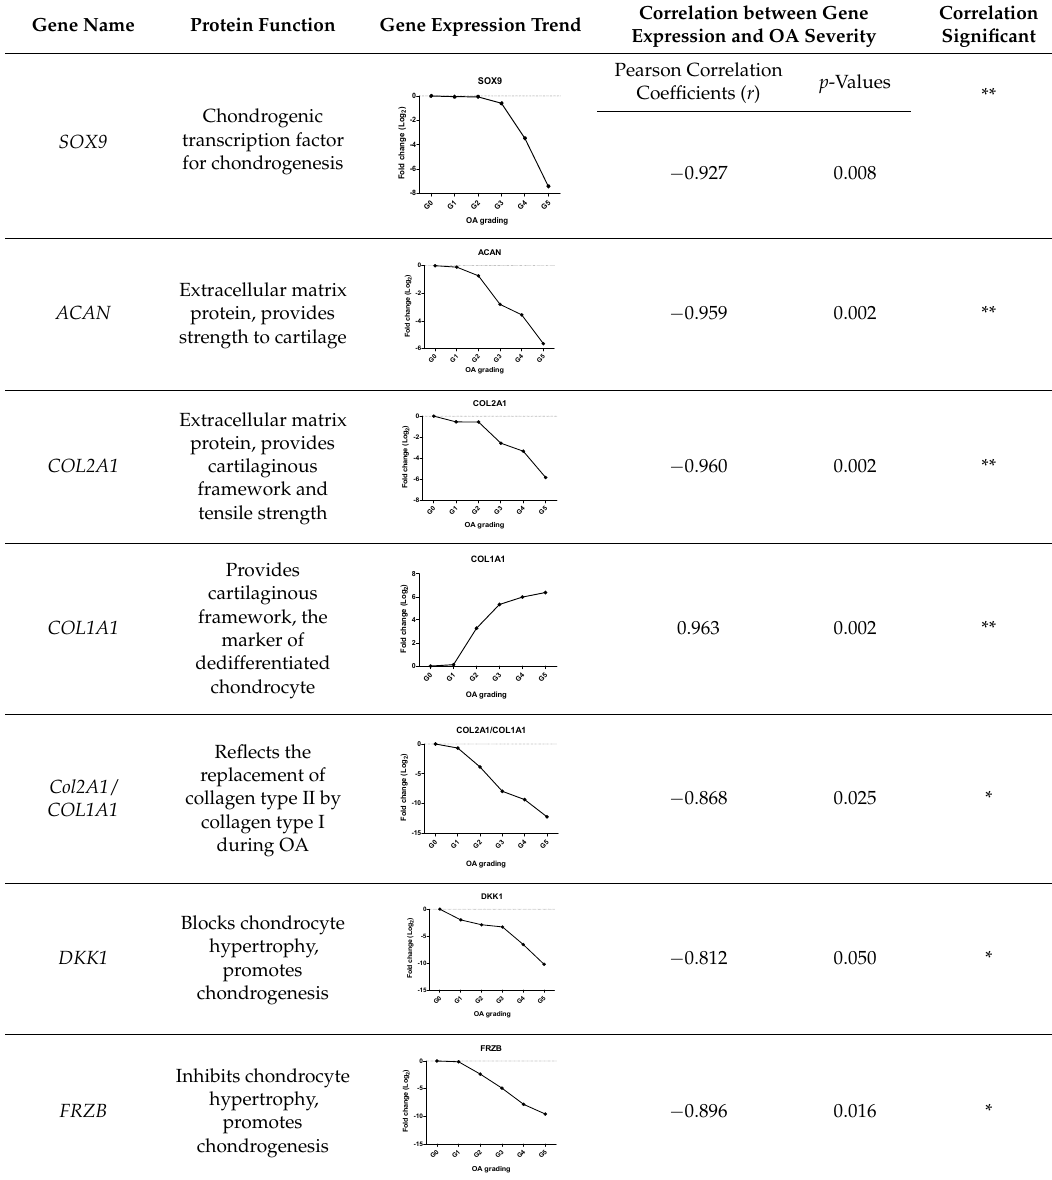
Table 1. Expression of cartilage-related genes in OA cartilage and correlation with the severity of OA ( n = 12). RT-PCR was performed to assess gene expression. Pearson correlation was used to examine the correlation between gene expression and the severity of OA. p < 0.05 was considered statistically correlated. ns: no correlation; * p < 0.05, ** p < 0.01: significant correlation.